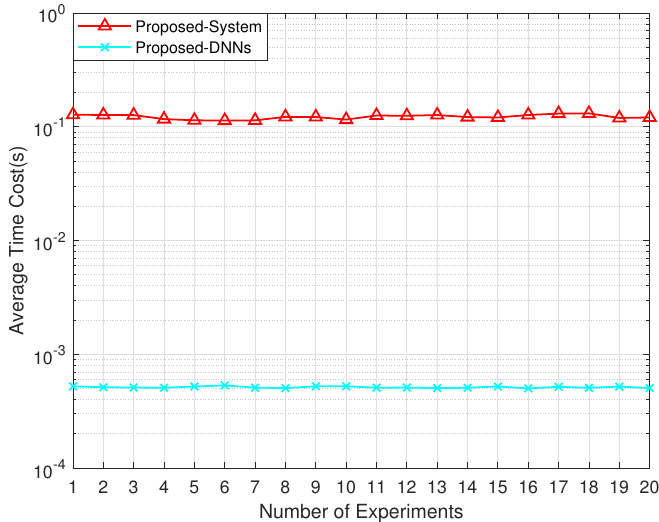
Figure 8. Average time cost for multiple